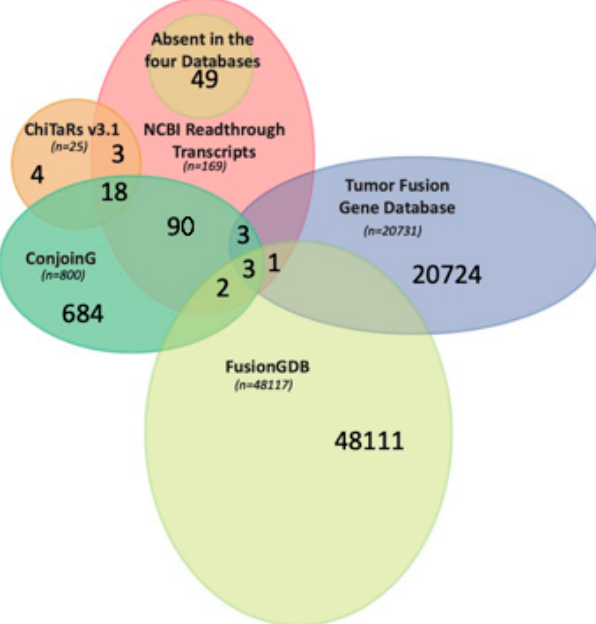
Figure 3. The Venn graph shows the comparison among ChiTaRs v3.1, ConjoinG, the Tumor Fusion Gene Database, Fusion GDB and NCBI readthrough transcripts. The data contained in each dataset are available in Table